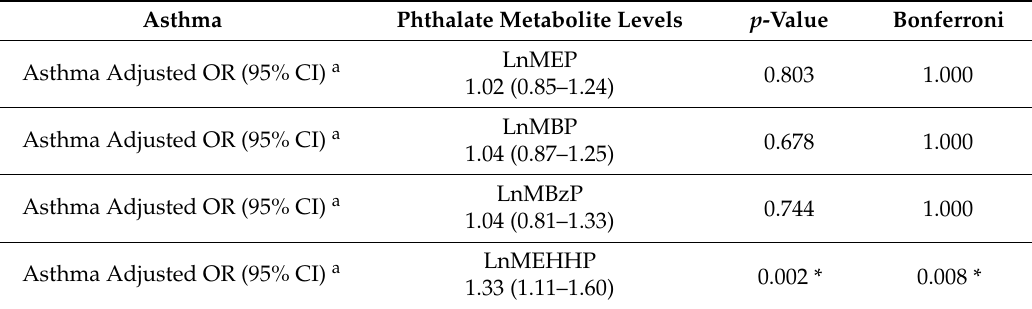
Table 2. The association of urine phthalate metabolite levels and asthma (both measured at 3 years of